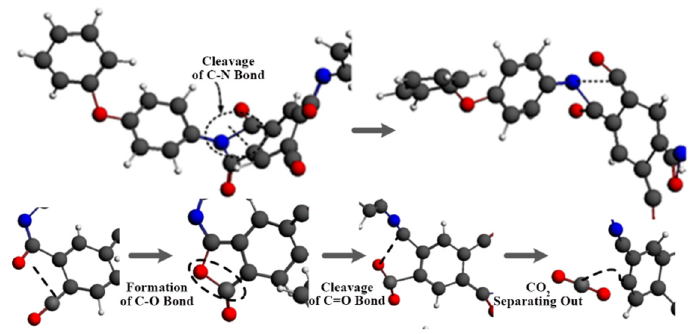
Figure 6. Microscopic process of PI pyrolysis.